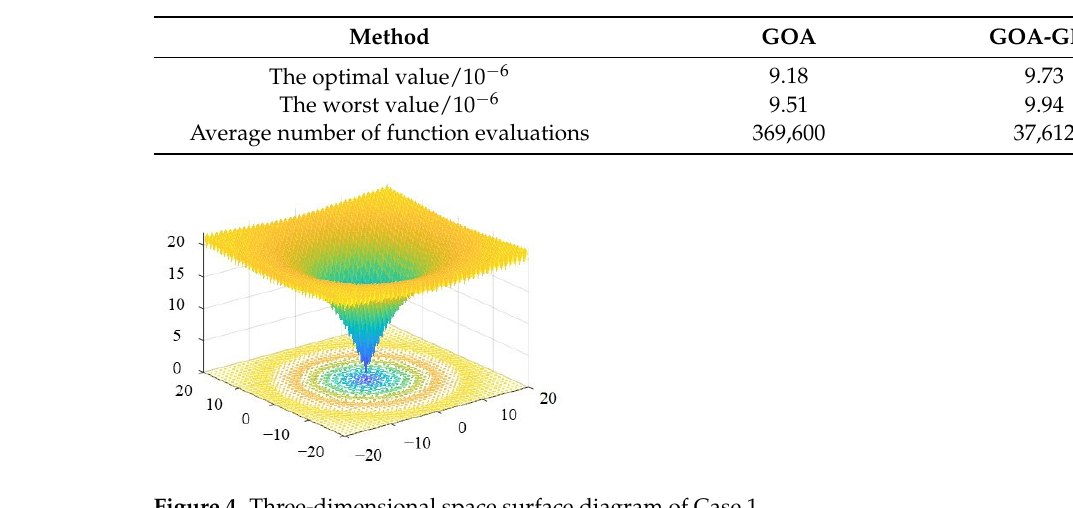
Table 1. Comparison of calculation results for Case 1.